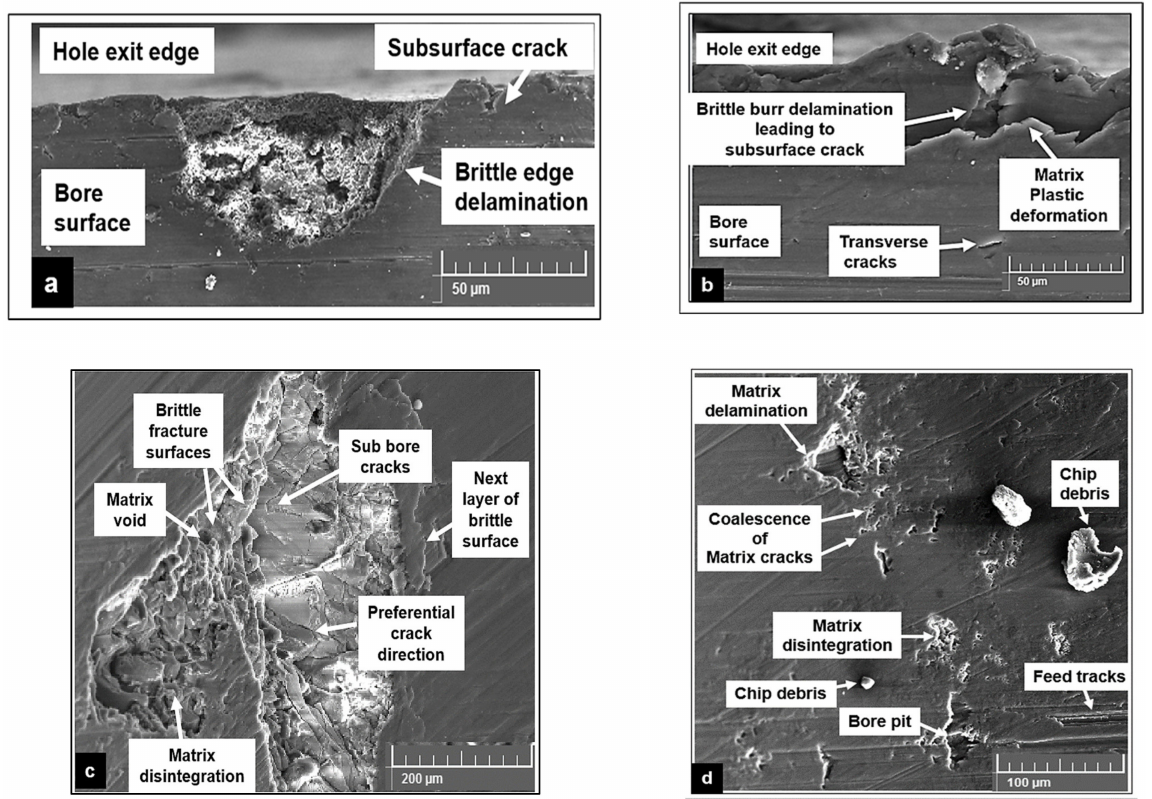
Figure 10. Some of the commonly found drilling-induced defects during machining of Mg-9Al-1.4Zn- based alumina syntactic foams: ( a ) Cryogenic. ( b ) Dry. ( c , d ) Wet Almag ® oil.